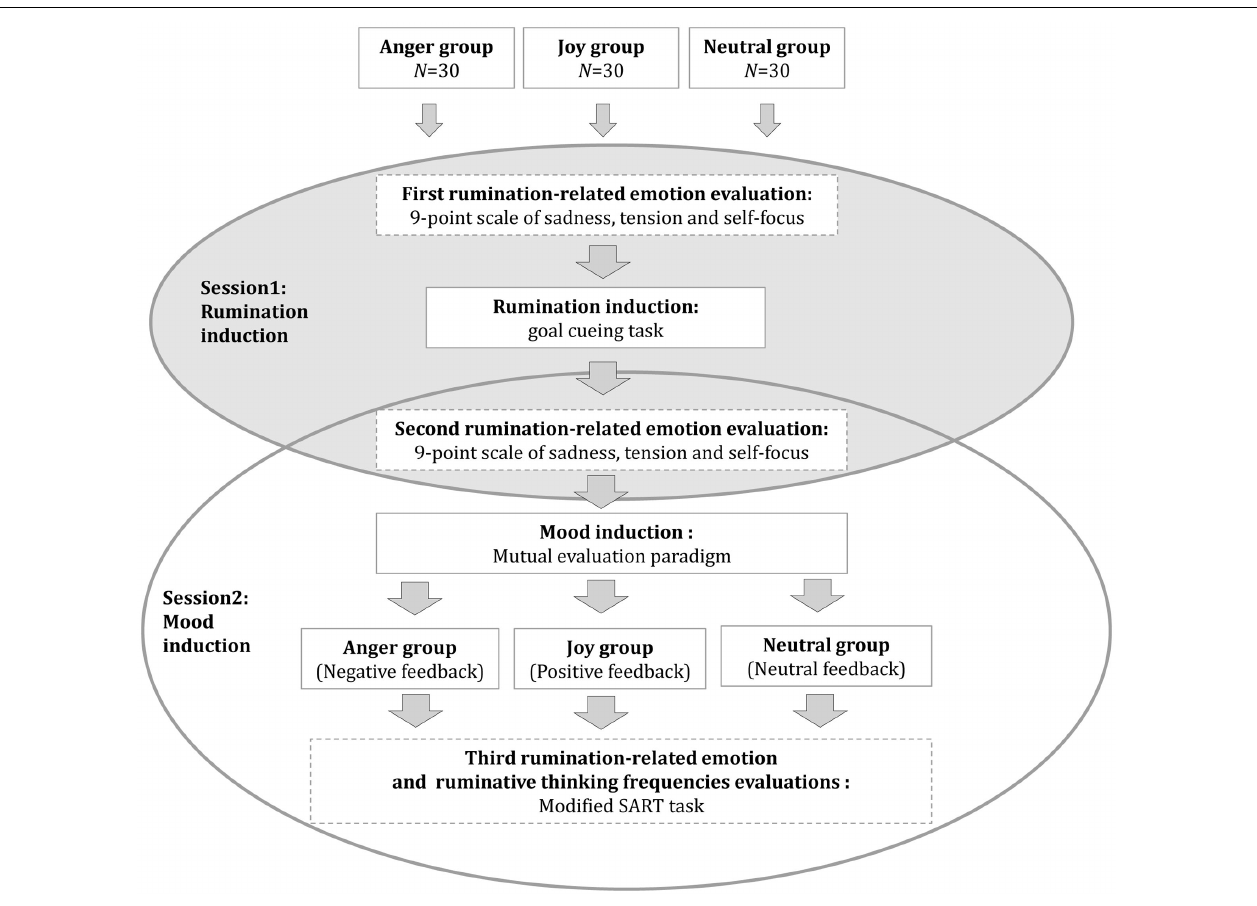
FIGURE 2 | Schematic illustration of the experimental procedure in Study